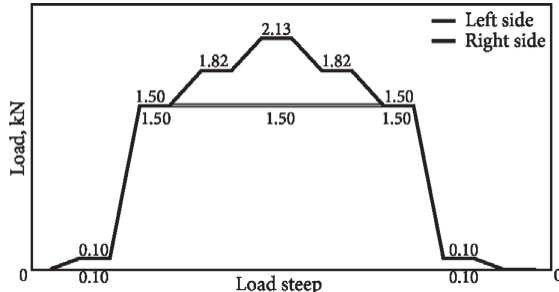
Fig. 5. Loading history of the engineering asymmetric load